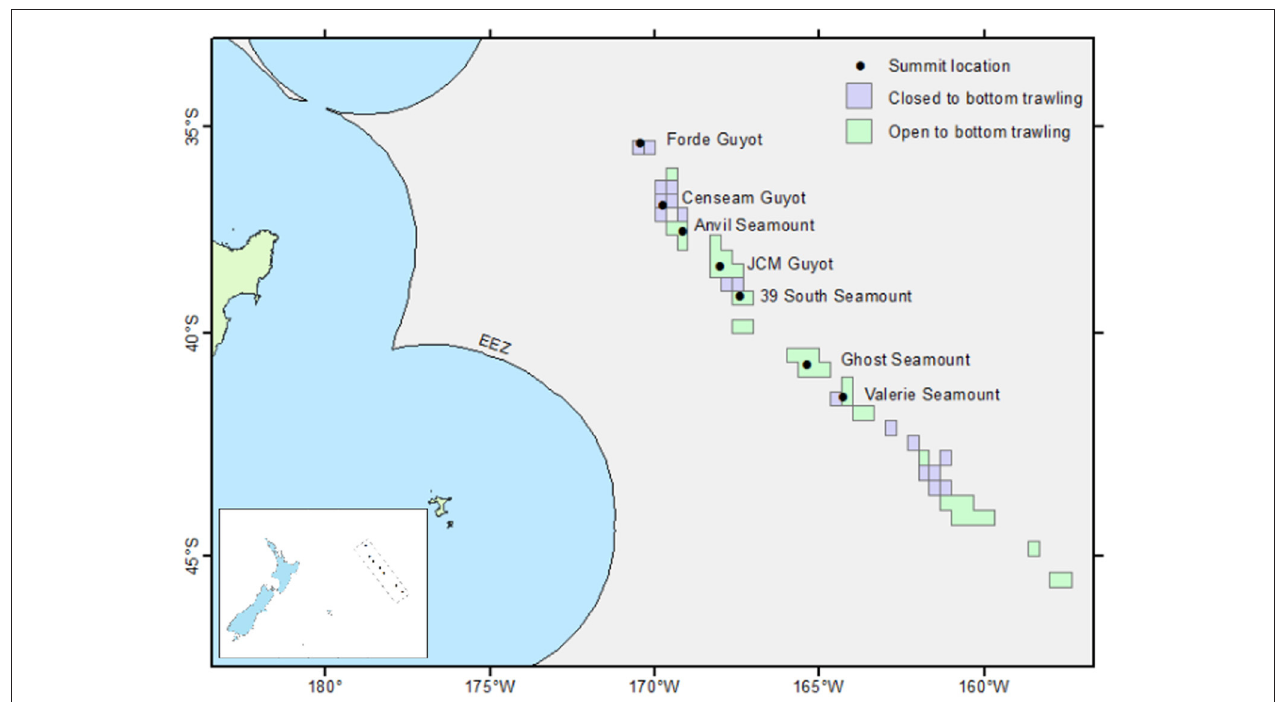
FIGURE 1 | Location of the surveyed seamounts and guyots within the Louisville Seamount Chain. Dots mark the location of the seamount summit, boxes mark areas open/closed to New Zealand bottom fishing. Inset image shows the location of the study area in relation to New Zealand.